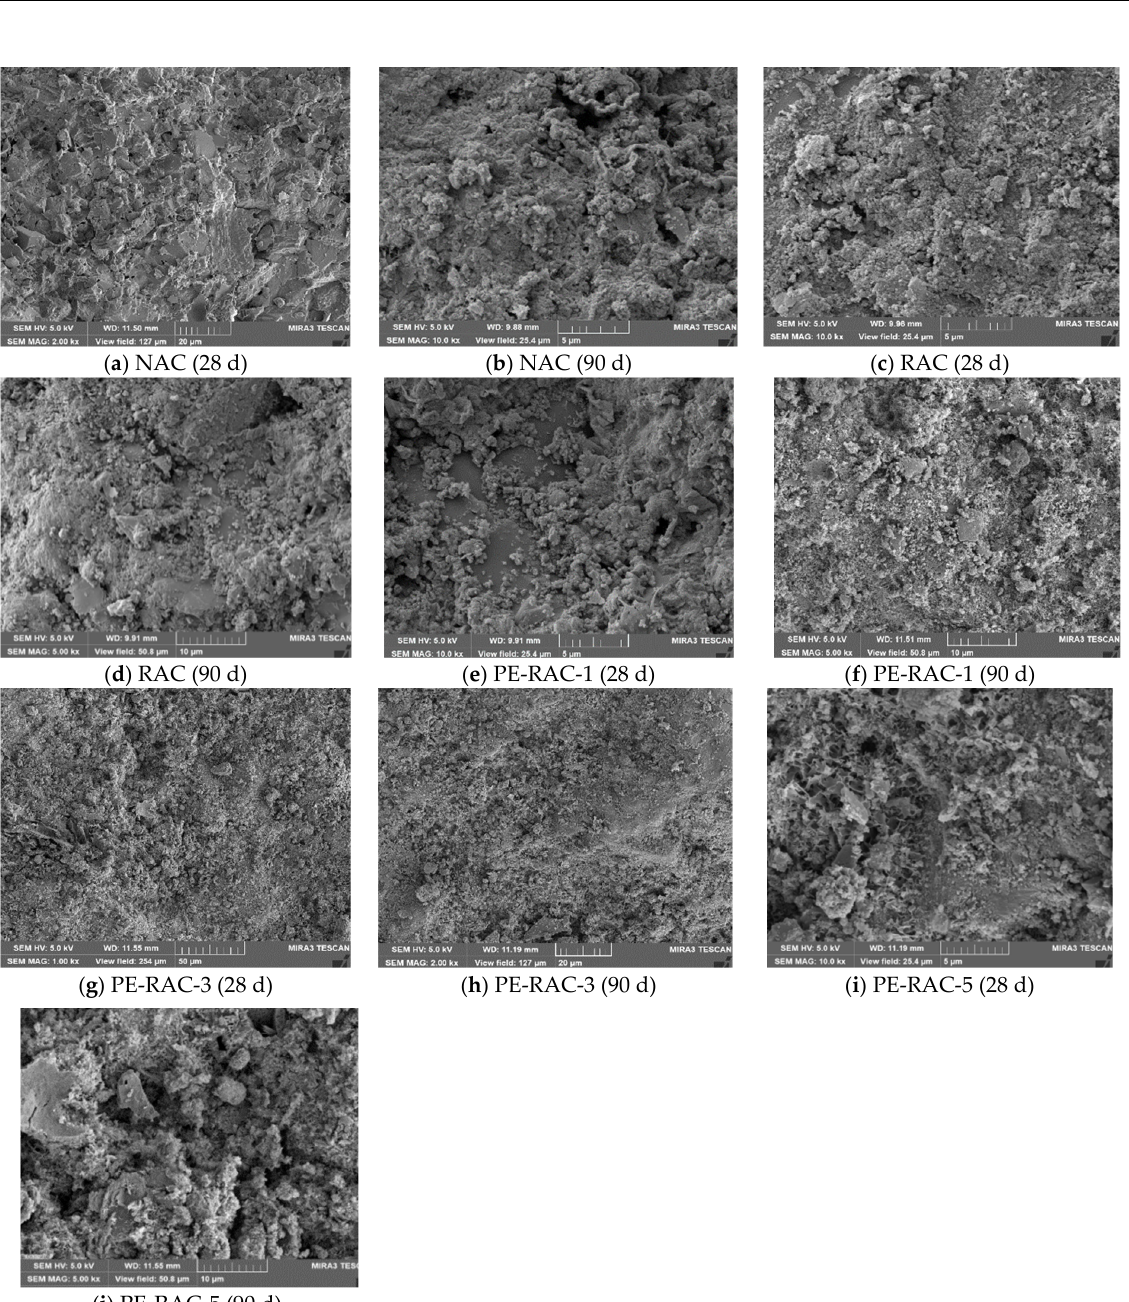
Figure 9. Comparative analysis diagram of curing coefficient in 28 d and 90 d.